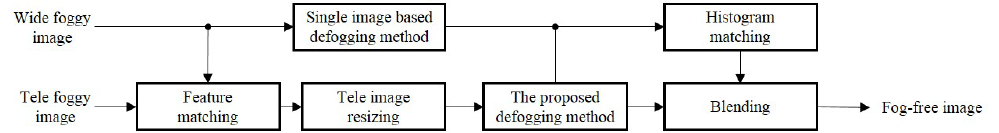
Figure 8. Block diagram of the proposed defogging algorithm applied to an asymmetric dual camera